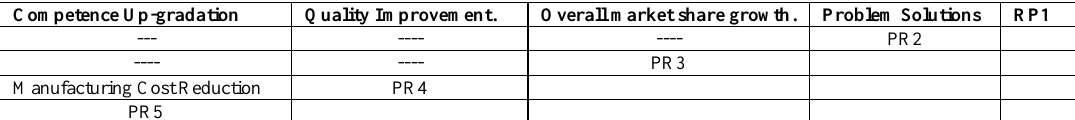
Table 7. Self-interaction interpretive matrix for process in interpretive